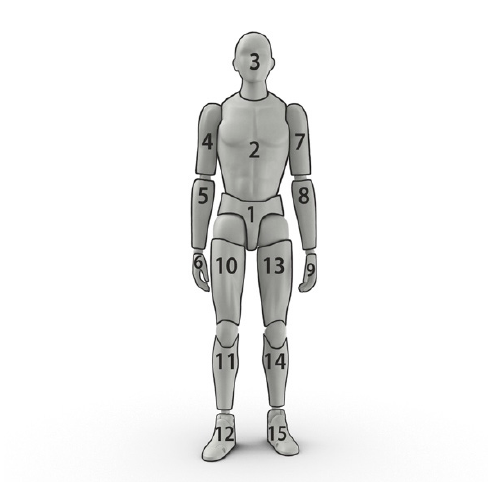
Figure 2. The segments of the whole-body model.